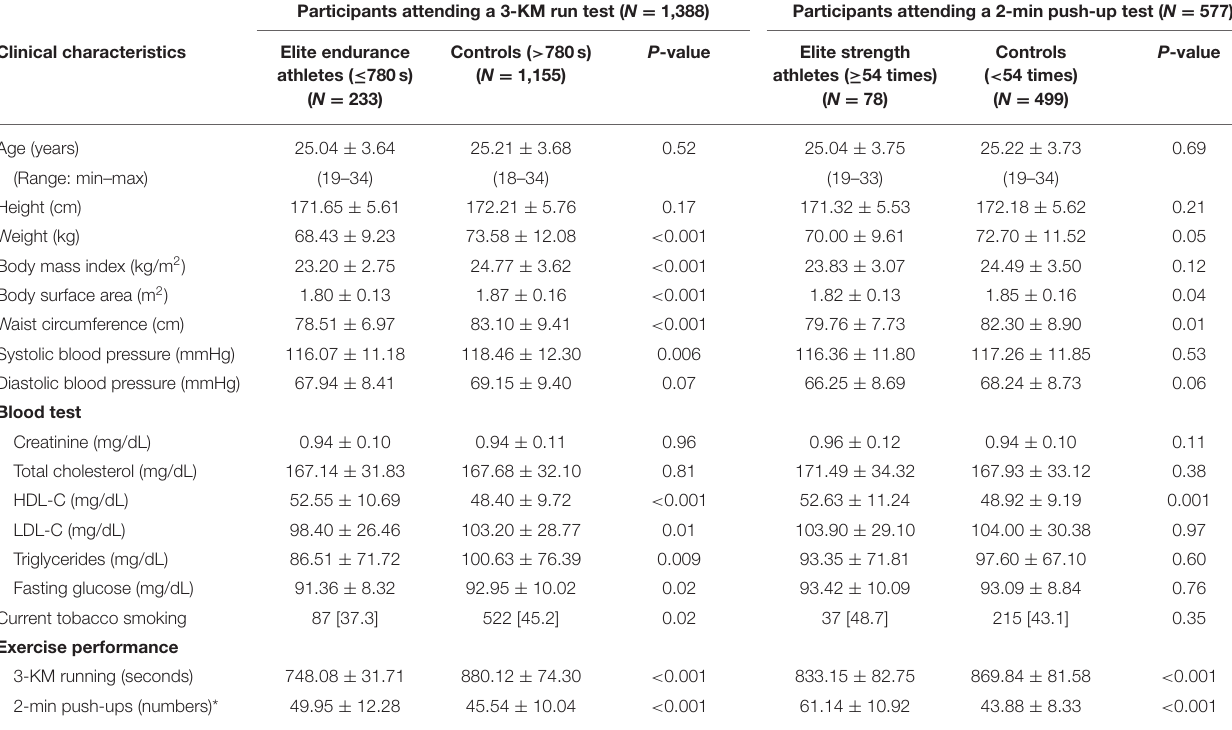
TABLE 1 | Clinical characteristics of elite endurance and strength athletes and non-elite controls. Participants attending a 3-KM run test ( N = 1,388) Participants attending a 2-min push-up test ( N =